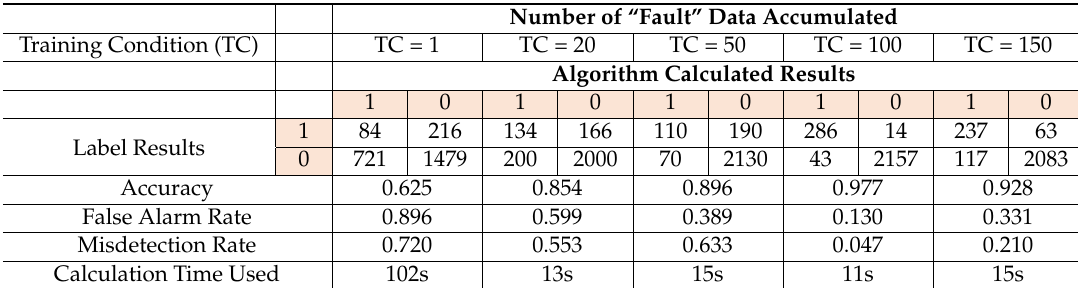
Table 1. Confusion matrix of fault and normal (1 and 0, respectively) detection results based on the proposed data-driven algorithm with different training strategies.